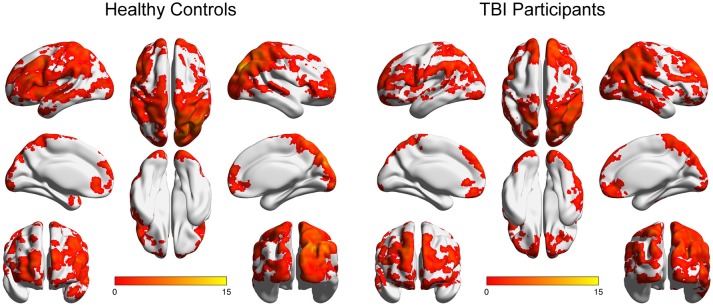
Within-group ICC maps for both groups. Results are presented on inflated brains created using the BrainNet tool (72). Images are displayed in neurological convention (left is left). Color scale represents t-score values.